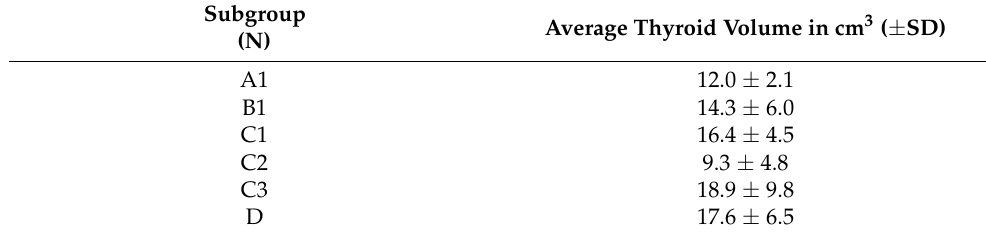
Table 3. Average volumes of the thyroid gland in the studied